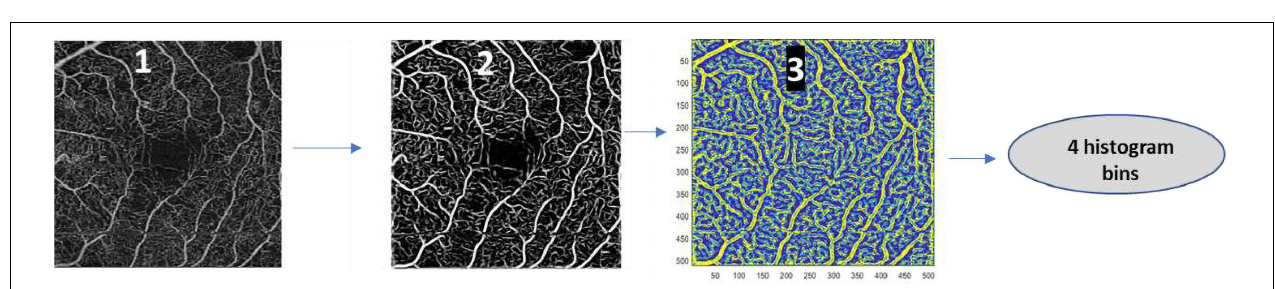
FIGURE 2 | Two examples of regions detected with the abnormal intercapillary spaces (AIS) method. From the left to the right: SCP en-face slab acquired from eyes with Early Treatment for Diabetic Retinopathy Study (ETDRS) 35, the corresponding binary image highlighted with the detected AIS and the binary image.